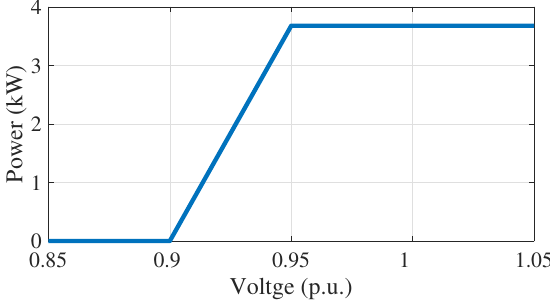
Figure 5. Droop curve of active power